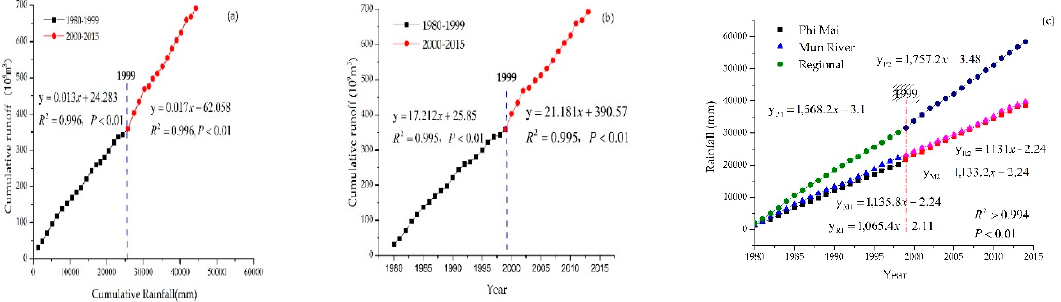
Figure 8. Cumulative variations of rainfall and runoff in the Mun River basin during 1980–2015: ( a ) Variation of cumulative runoff against cumulative rainfall; ( b ) Variation of cumulative runoff with time; and ( c ) Variation of cumulative rainfall with time. Table 3. The periodical characteristics of runo ff and rainfall variation in the Mun River basin. Table 4. Values and variations of slope calculated from the cumulative curves of rainfall against Runo ff -Rainfall runoff